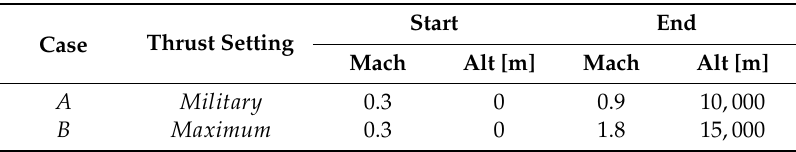
Table 5. Test case